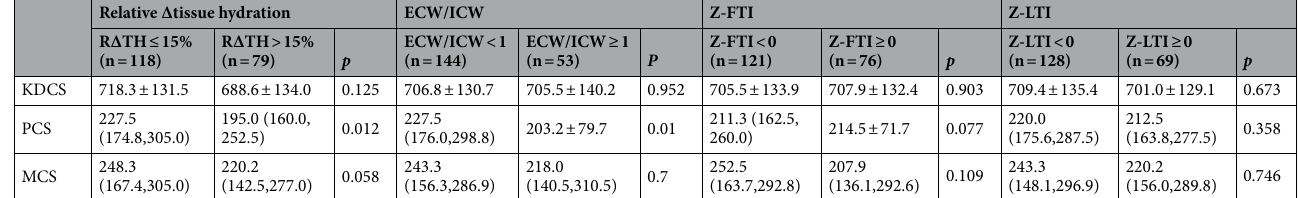
Table 2. HRQOL scores: Comparison between various body composition status. HRQOL health related quality of life, R∆TH Relative ∆tissue hydration, ECW extracellular water, ICW intracellular water, Z-FTI